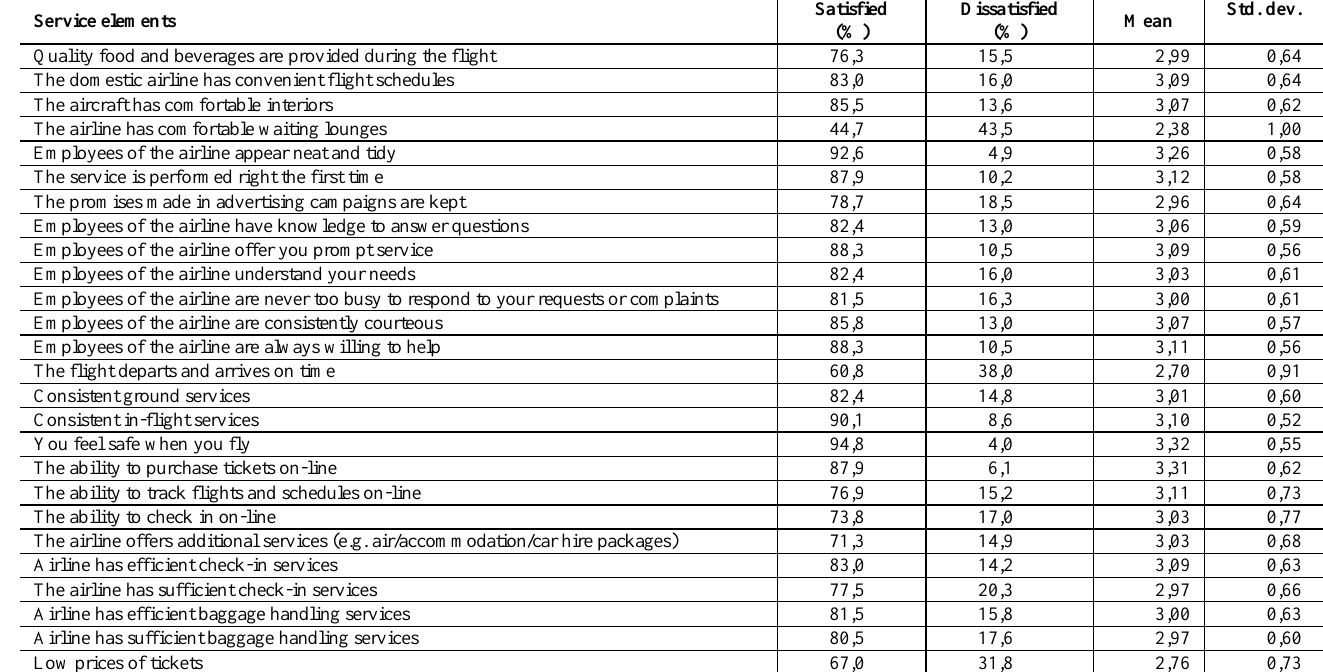
Table 1: Respondents’ satisfaction with service elements Service elements